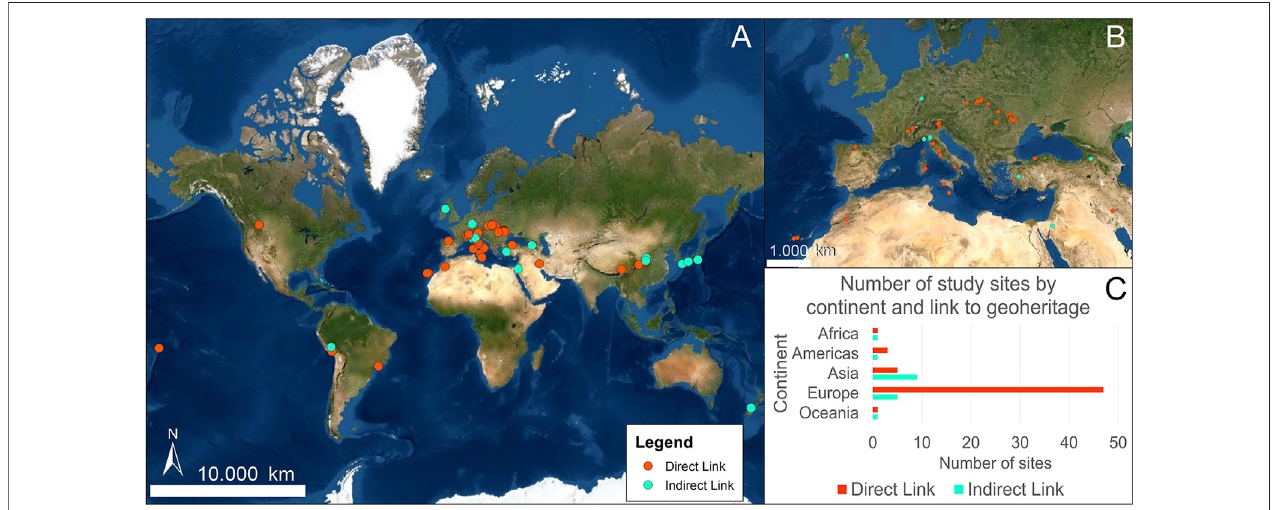
FIGURE 2 | (A) World Map of the study sites in publications that record a Direct or an Indirect link between landslides and the geological heritage. Base map from WorldImageryprovidessatelliteandaerialimageryworldwide,andfeaturesimageryfromEsri,Maxar,GeoEye,EarthstarGeographics,CNES/AirbusDS,USDA,USGS, AeroGRID, IGN, and the GIS User Community. (B) Map of the study sites in publications that record a Direct or an Indirect link between landslides and the geological heritage in Europe. (C) Column chart of the number of study sites by continent in publications having a Direct or an Indirect link between landslides and the geological